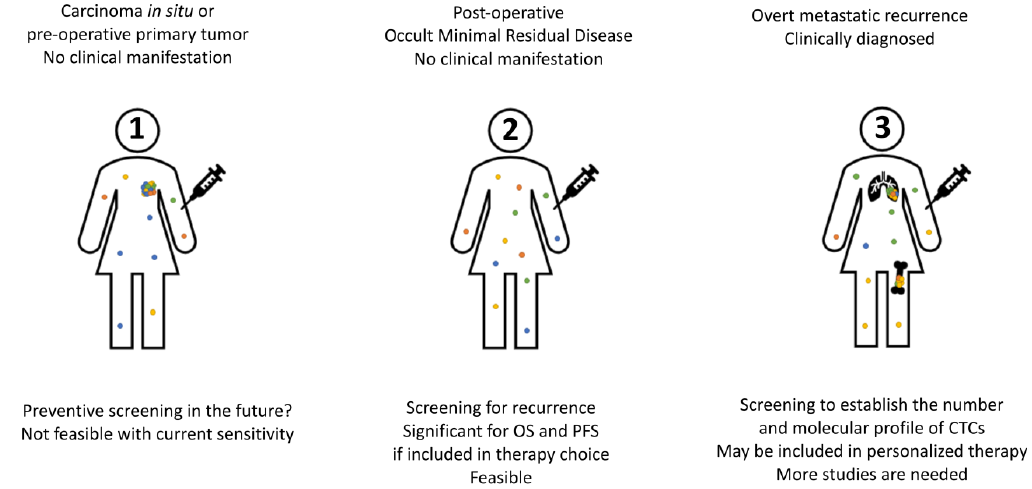
Figure 3. Possible use of CTC assessment in clinical practice. ( 1 ) Screening the healthy population may represent a future approach for early detection, but more sensitive methods are needed for this approach to be feasible. ( 2 ) Monitoring post-operative patients to flag possible recurrence is feasible and currently tested in clinical trials. ( 3 ) At present in metastatic breast cancer CTC analysis may be used for patients’ stratification. Molecular characterization of tumor cells may be used in the future to adjust the treatment.